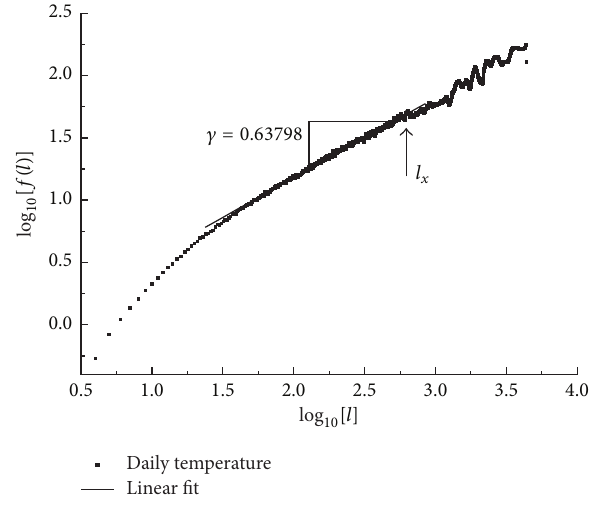
Figure 3: DFA2 curve of daily average maximum temperatures at Xi’an Station during the period of